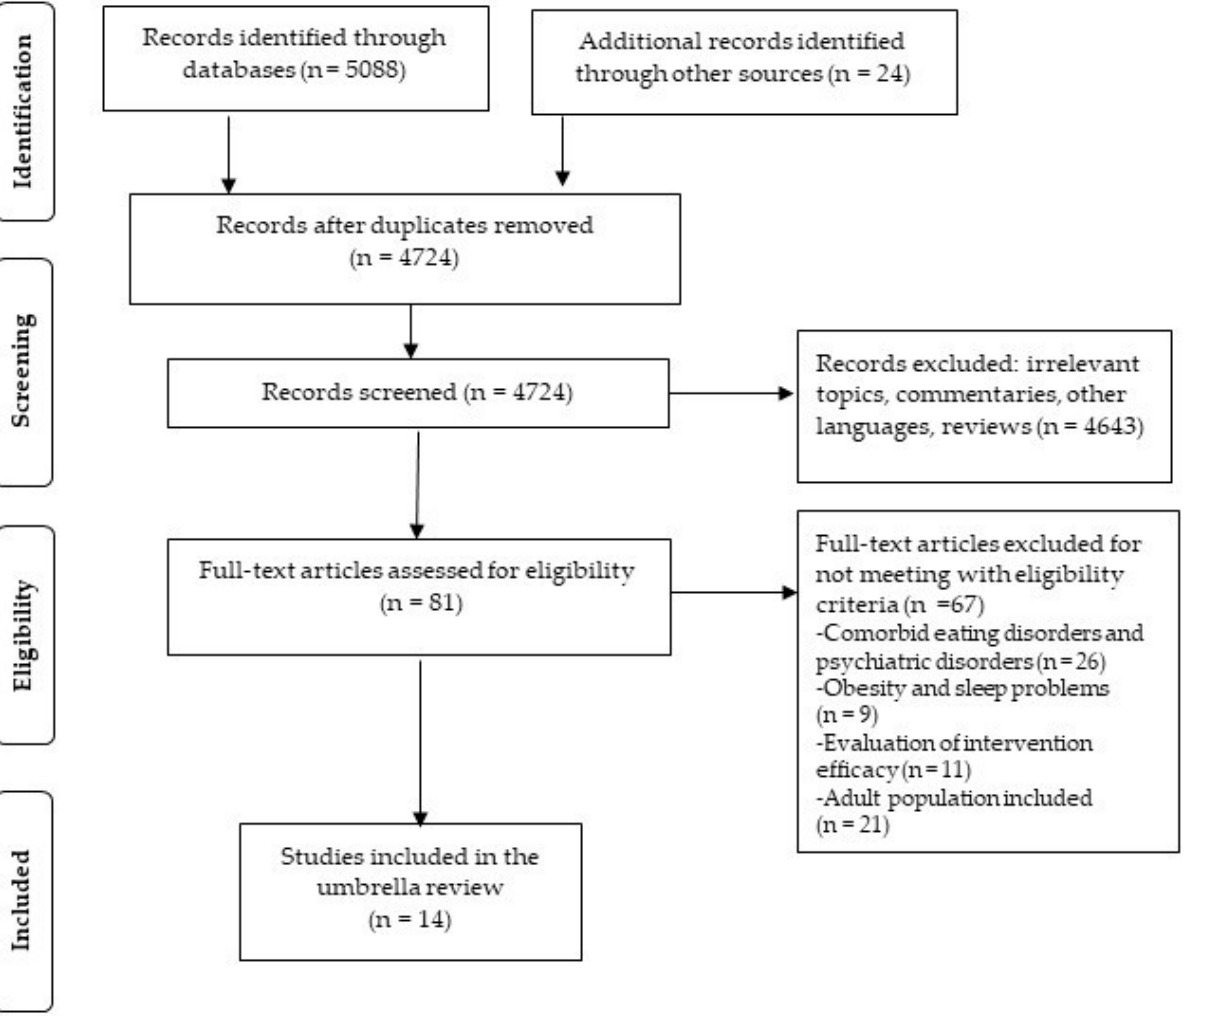
Figure 2. Study selection flowchart.